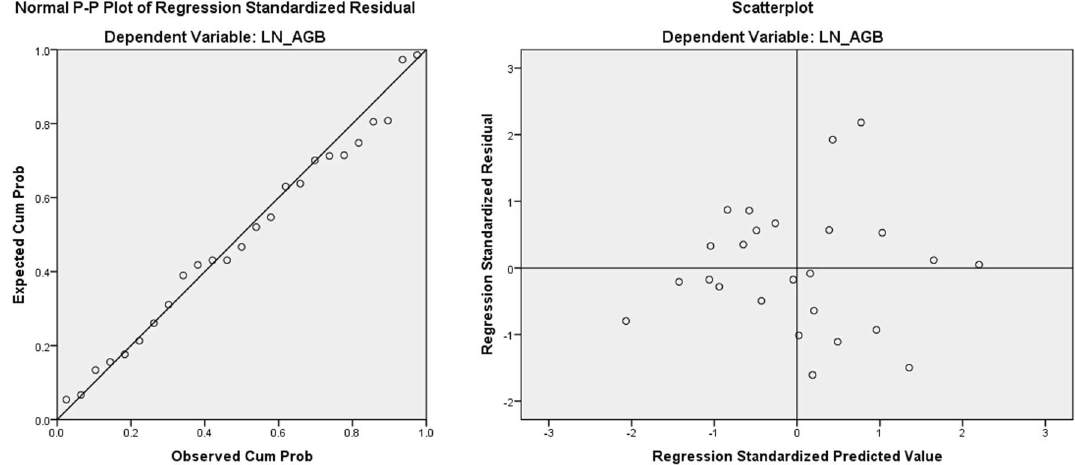
Figure 7. Model II—10 m radius plot model ( a ) residual normal P–P plot and ( b ) residual scatter plots. The results suggested the model residuals were normally distributed and homoscedastic.